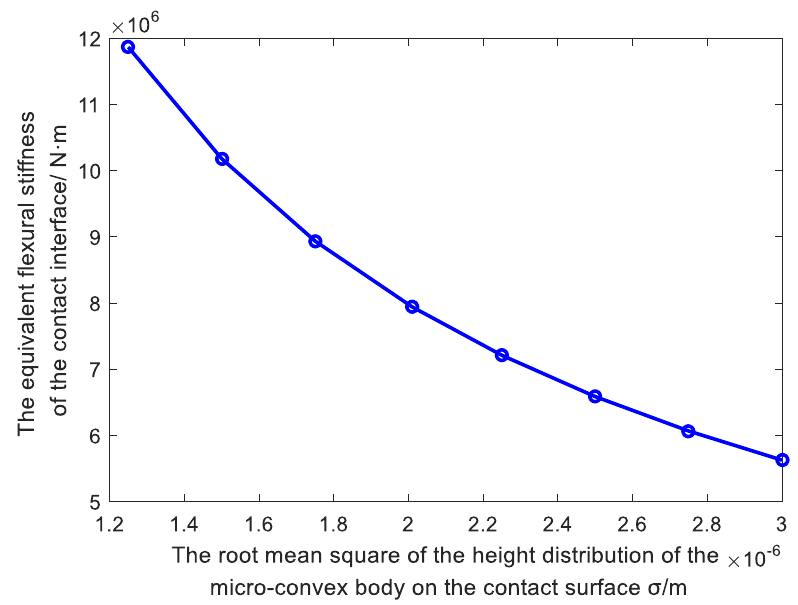
Figure 8. EFS of the contact surface changes with the root mean square of the micro-convex body distribution.